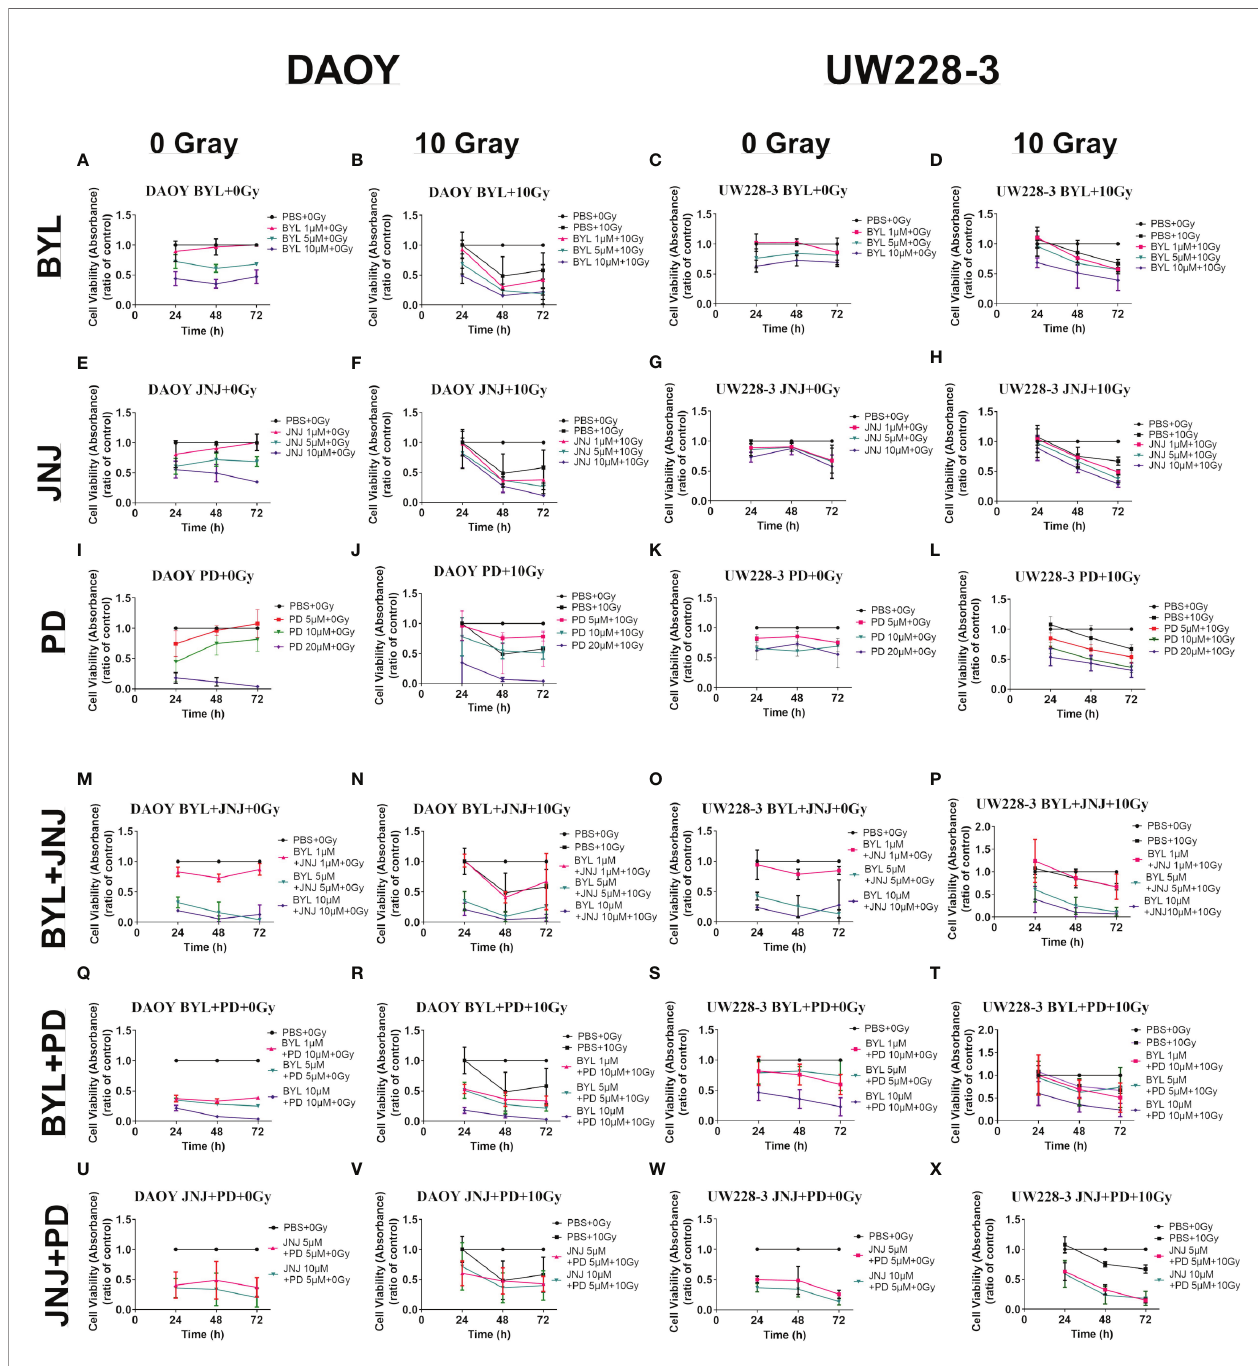
FIGURE 6 | WST-1 viability assays of the MB cell lines DAOY and UW228-3 fi rst treated with single or combinational treatment of PI3K, FGFR, and CDK4/6 inhibitors BYL719, JNJ-42756493, and PD-0332991, respectively, and then not irradiated (0 Gy) or irradiated 3 h later with 10 Gy. Viability analysis measured as absorbance, after treatment for 24, 48, and 72 h with BYL719 (A – D) , JNJ-42756493 (E – H) ; and PD-0332991 (I – L) , of DAOY and UW228-3, respectively. Their combinations are shown for DAOY (M, N, Q, R, U, V) and for UW228-3 (O, P, S, T, W, X) . BYL, BYL719; JNJ, JNJ-42756493; PD, PD-0332991; Gy, Gray; MB,